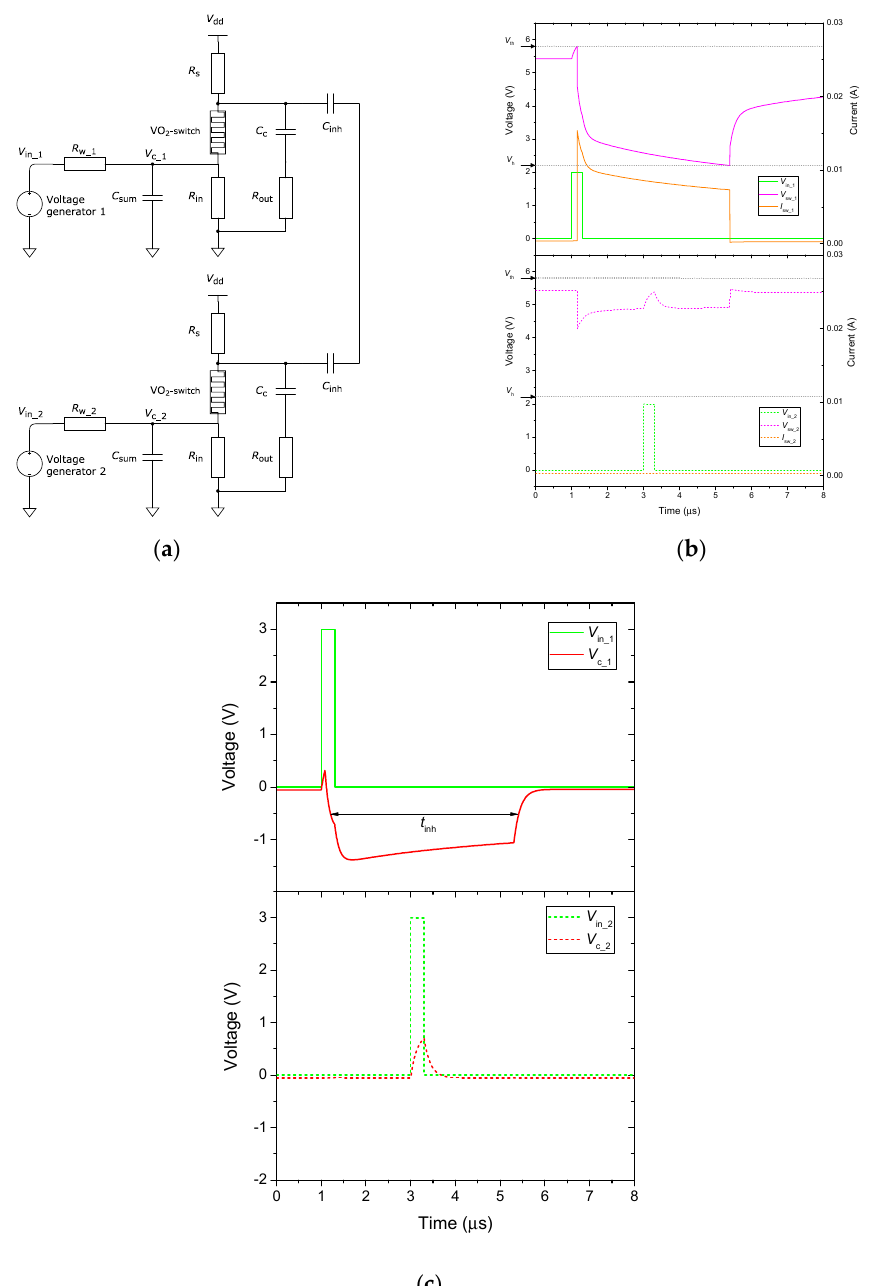
Figure 5. ( a ) Connection diagram of two oscillators with inhibitory connections. ( b ) Oscillograms of the input signals V in_1 , V in_2 , voltages V sw_1 , V sw_2 and currents I sw_1 , I sw_2 on the switches, and ( c ) oscillograms of the input signals V in_1 , V in_2 and voltages on the integrating capacitors V c_1 , V c_2 , when applying two voltage pulses with a delay of 2 μ s.